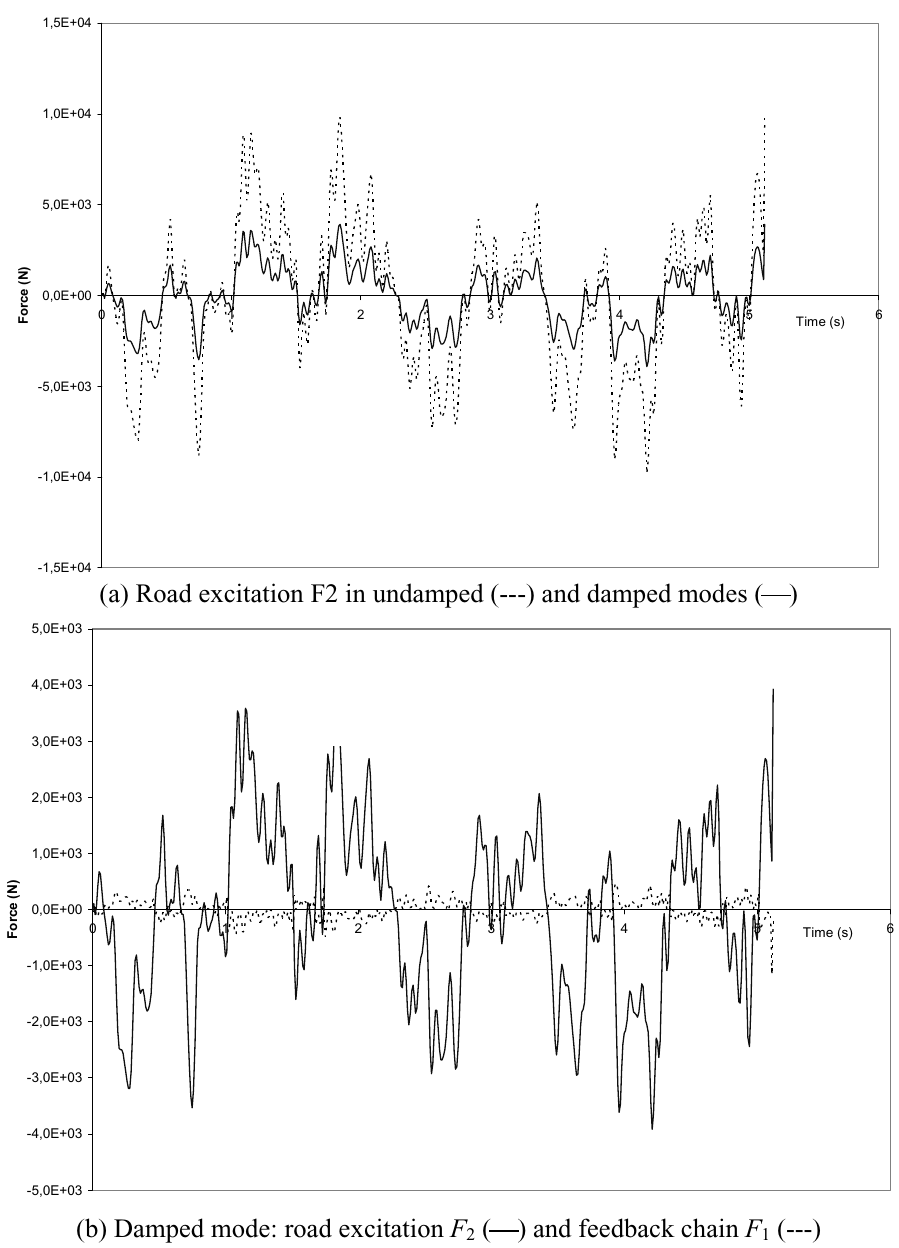
Fig. 4. Different force spectrums in the vehicle control suspension